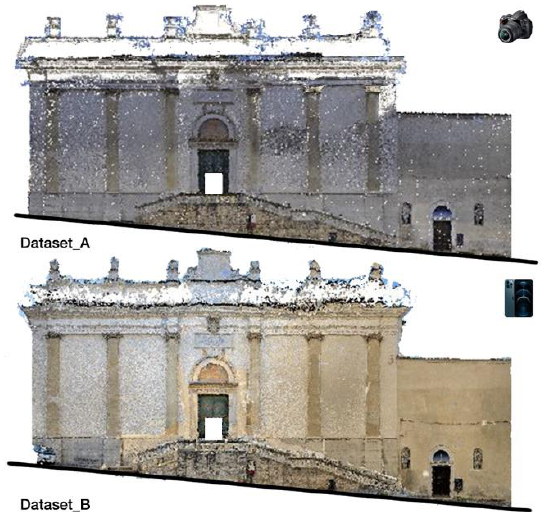
Figure 6. Above point cloud acquired by NikonD5000 digital camera (A) below point cloud acquired by iPhone 12PRO (B).